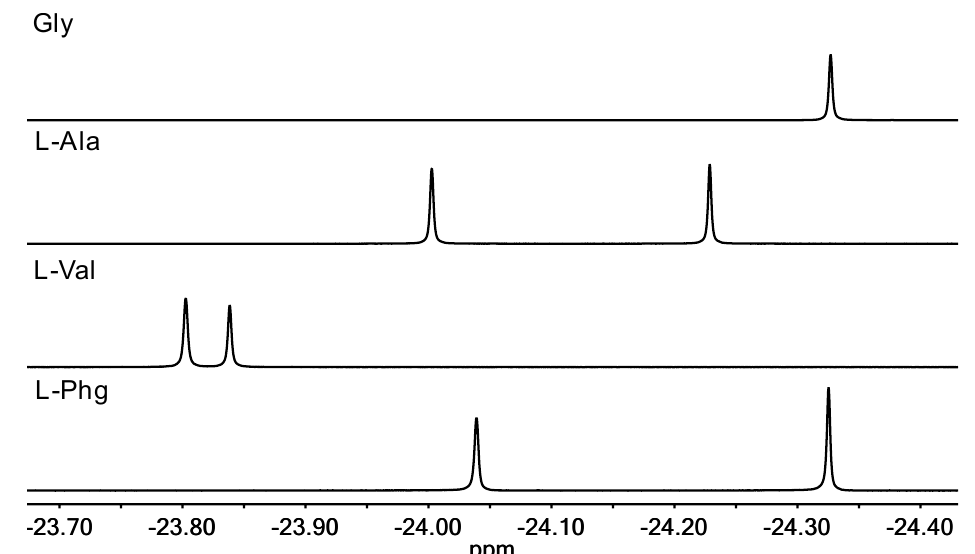
Figure 7. 1 H NMR spectra (400 MHz, DMSO- d 6 ) showing the hydride resonances for complexes of the form Ir(IMe) 2 (aa)(H)(I), where aa = glycine, L -alanine, L -valine, and L -phenylglycine.